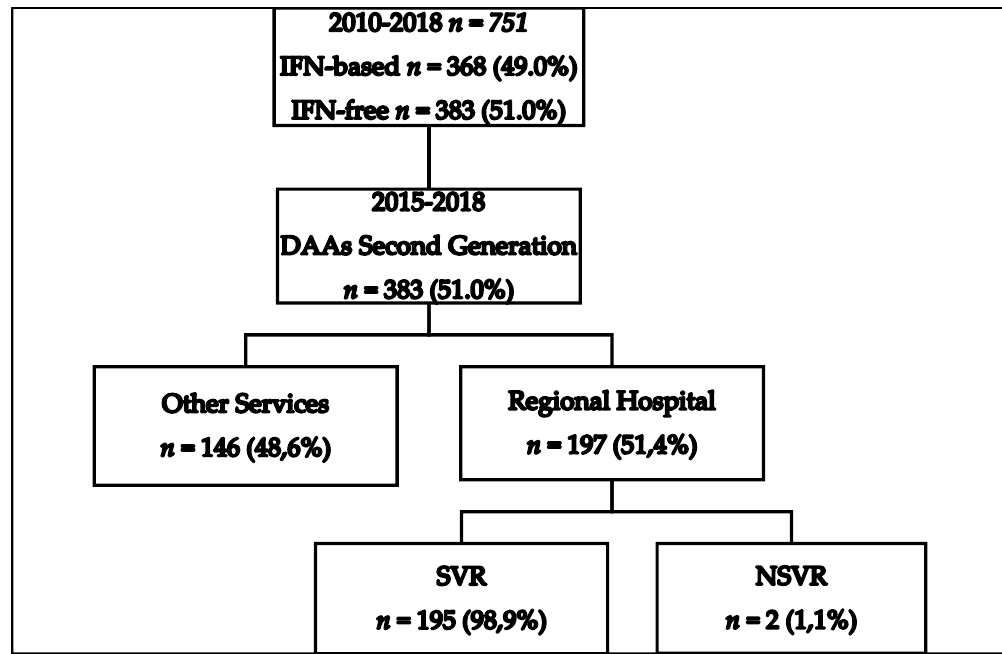
Figure1. FlowchartofpatientsdiagnosedwithhepatitisCvirus(HCV)intheRegionalHealthAssistance Network11 (RHAN11) mesoregion from 2010 to 2018 and treated with first- and second-generation direct-action antivirals (DAAs). IFN-based, interferon-based; NSVR, non-sustained viral response; SVR, sustained viral response.